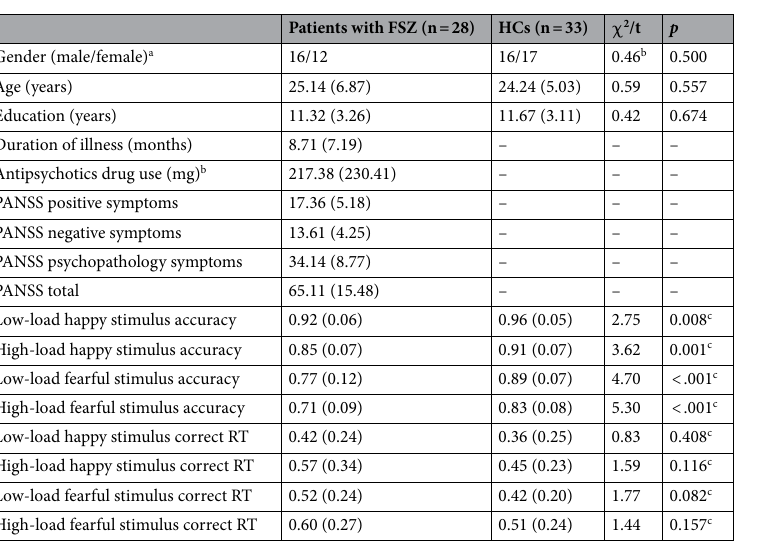
Table 1. Clinical, demographic characteristics and FER ability of the participants. Values are presented as mean (SD). PANSS, Positive and Negative Syndrome Scale; FSZ, First-episode schizophrenia; HCs, Healthy controls; RT, Reaction time. a Chi-square test; b equivalent to Chlorpromazine dosage; c Significantly different between two groups after Bonferroni adjustments ( p <